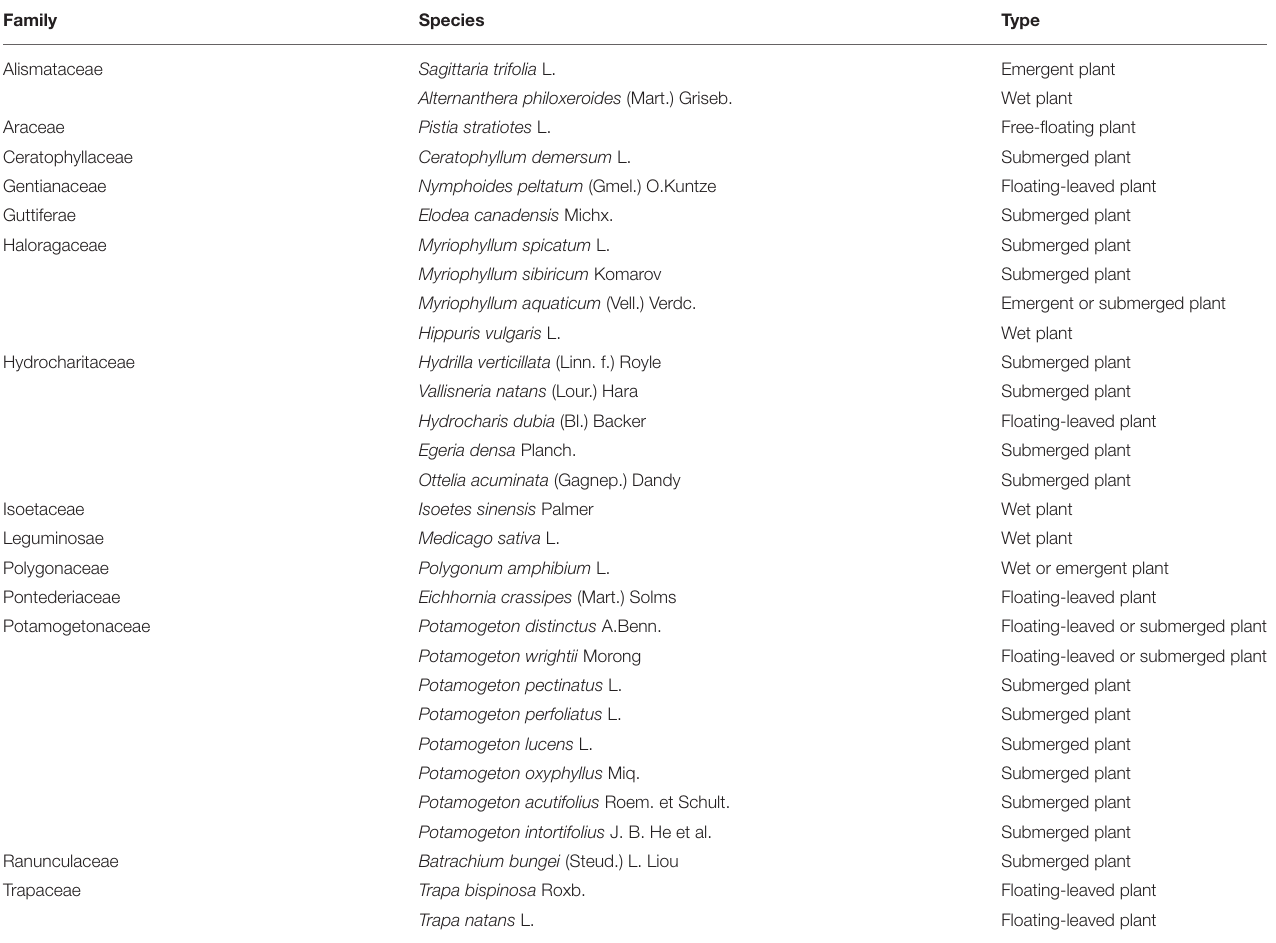
TABLE 1 | Family and species information of the 30 aquatic plant species collected from Southwest